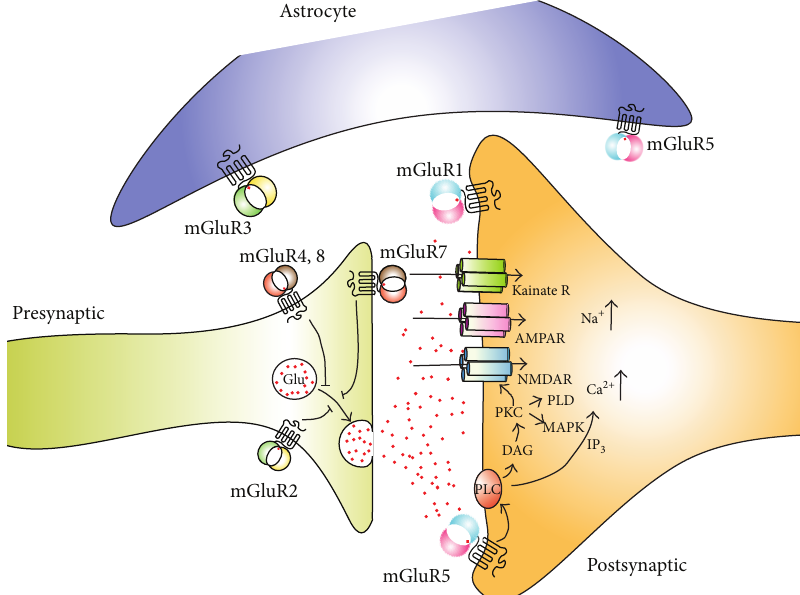
Figure 1: Schematic representation of ionotropic and metabotropic glutamate receptor subtypes, their intracellular function, and synaptic localization. AMPAR: 𝛼 -amino-3-hydroxy-5-methyl-4-isoxazolepropionic acid receptor, DAG: diacylglycerol, iGluR: ionotropic glutamate receptor, IP 3 : inositol (1,4,5)-triphosphate, MAPK: mitogen-activated protein kinase, mGluR: metabotropic glutamate receptor, NMDAR: N-methyl-d-aspartate receptor, PKC: protein kinase C, PLC: phospholipase C, PLD: phospholipase D (reproduced with permission from Novartis Pharma AG. 2008